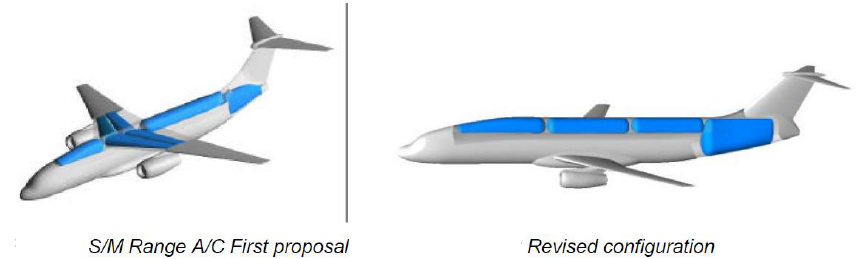
Figure 17. Schematic of the initial small–medium range (SMR) aircraft configuration and the revised aircraft configuration with cryogenic tanks.